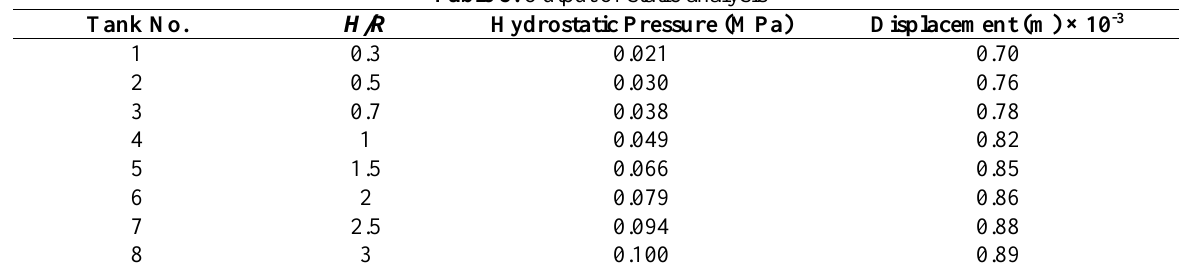
Table 5. Output of static analysis